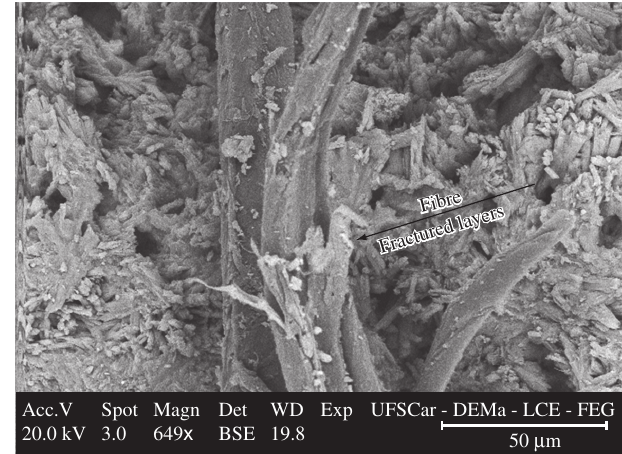
Figure 10. SEM and secondary electron images. Matrix containing 10% of cellulose pulp.